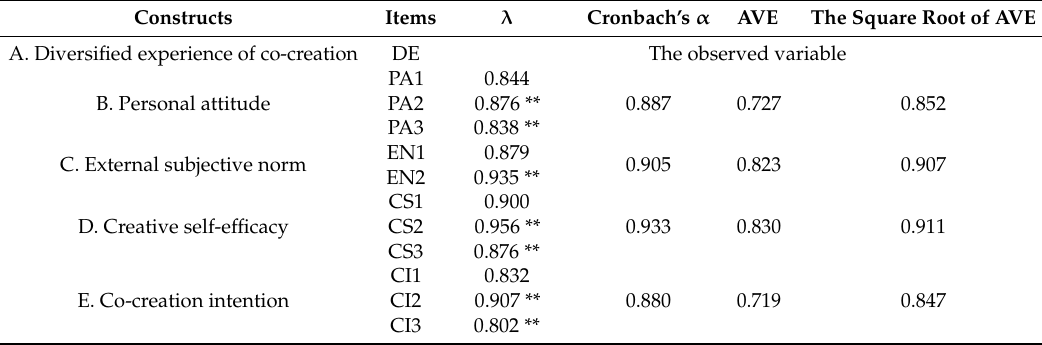
Table 3. Analysis of reliability and convergent and discriminant validity of the measurement model. AVE: average variance